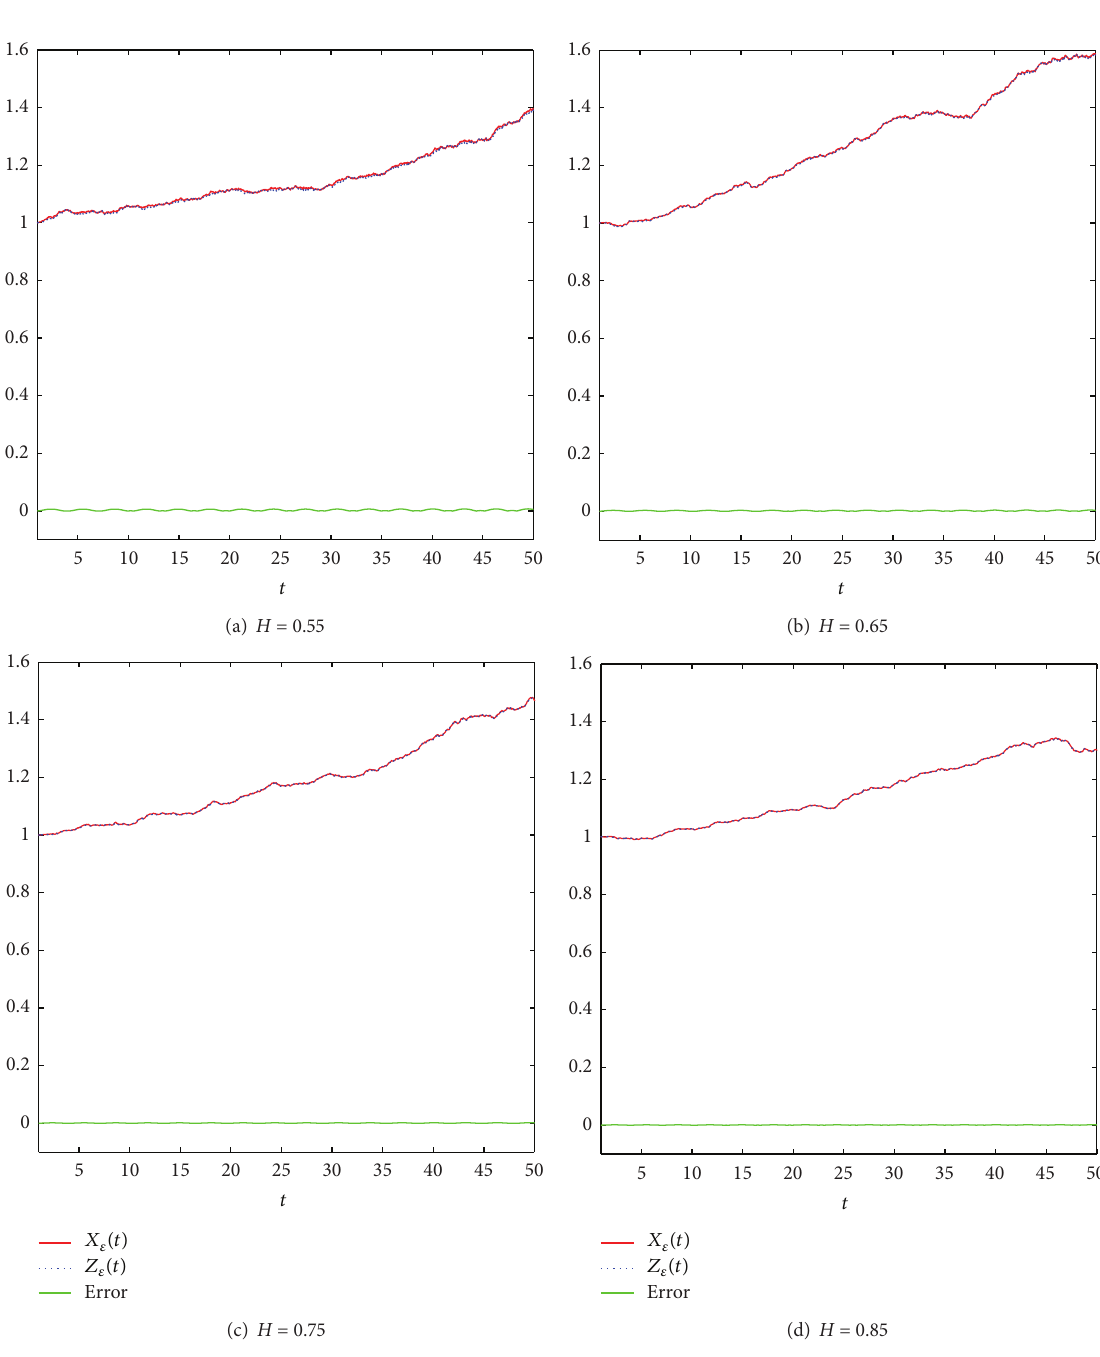
Figure 1: Comparison of the exact solution 𝑋 𝜀 (𝑡) with the averaged solution 𝑍 𝜀 (𝑡) for (47) and (50) with 𝑋(0) = 1 , 𝑎 = 0.2 , 𝑐 = 0.1 , 𝜀 = 0.045 , and different 𝐻